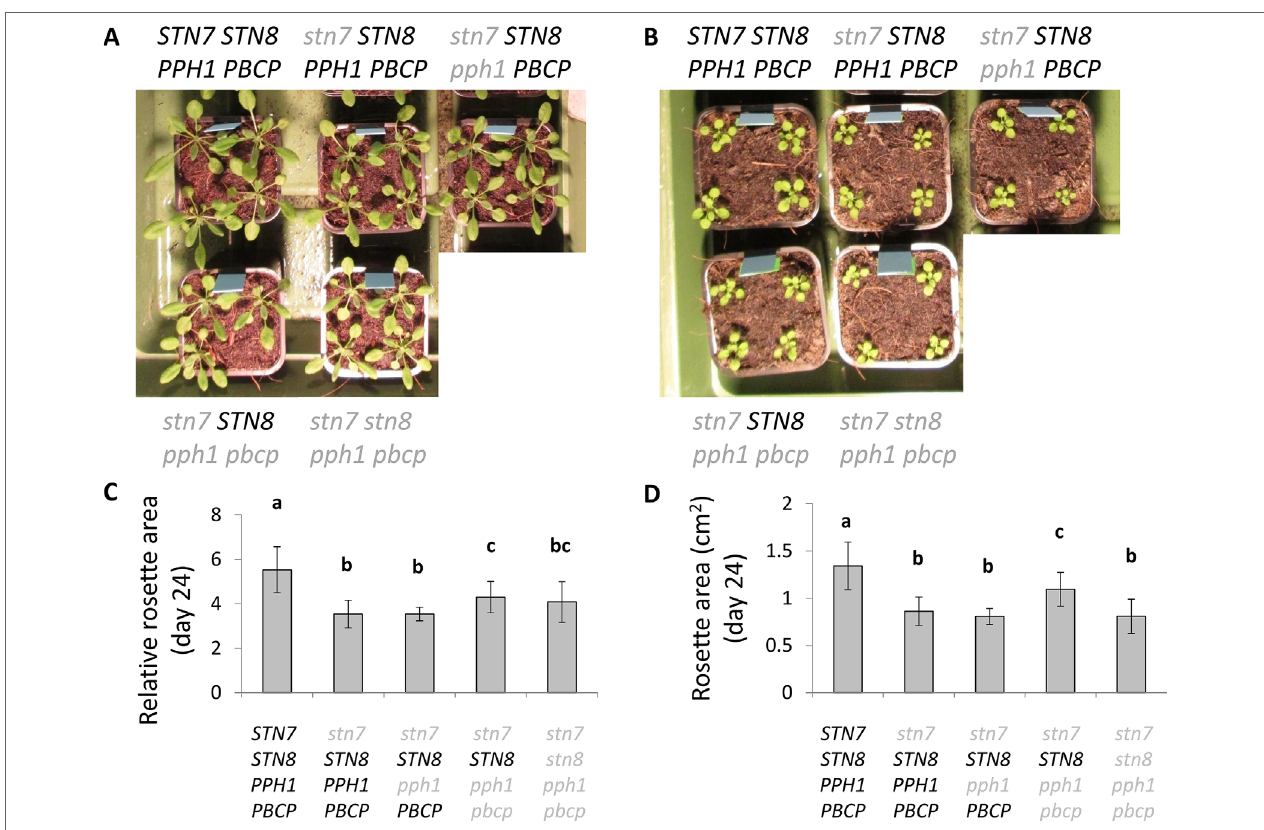
FIGURE 7 | Growth of the plants and rosette area under fluctuating light intensity. (A , B) : Plants were grown under a long day cycle with during the day either (A) a constant light intensity (100 µmol photons m −2 s −1 ) or (B) a fluctuating light intensity with 4 min at 50 µmol photons m −2 s −1 and 1 min at 500 µmol photons m −2 s −1 . The picture shows a representative set of plants for each tested genotype. (C , D) : Comparison of rosette size at day 24 for the different genotypes grown under the fluctuating light regime, expressed as relative rosette area compared to day